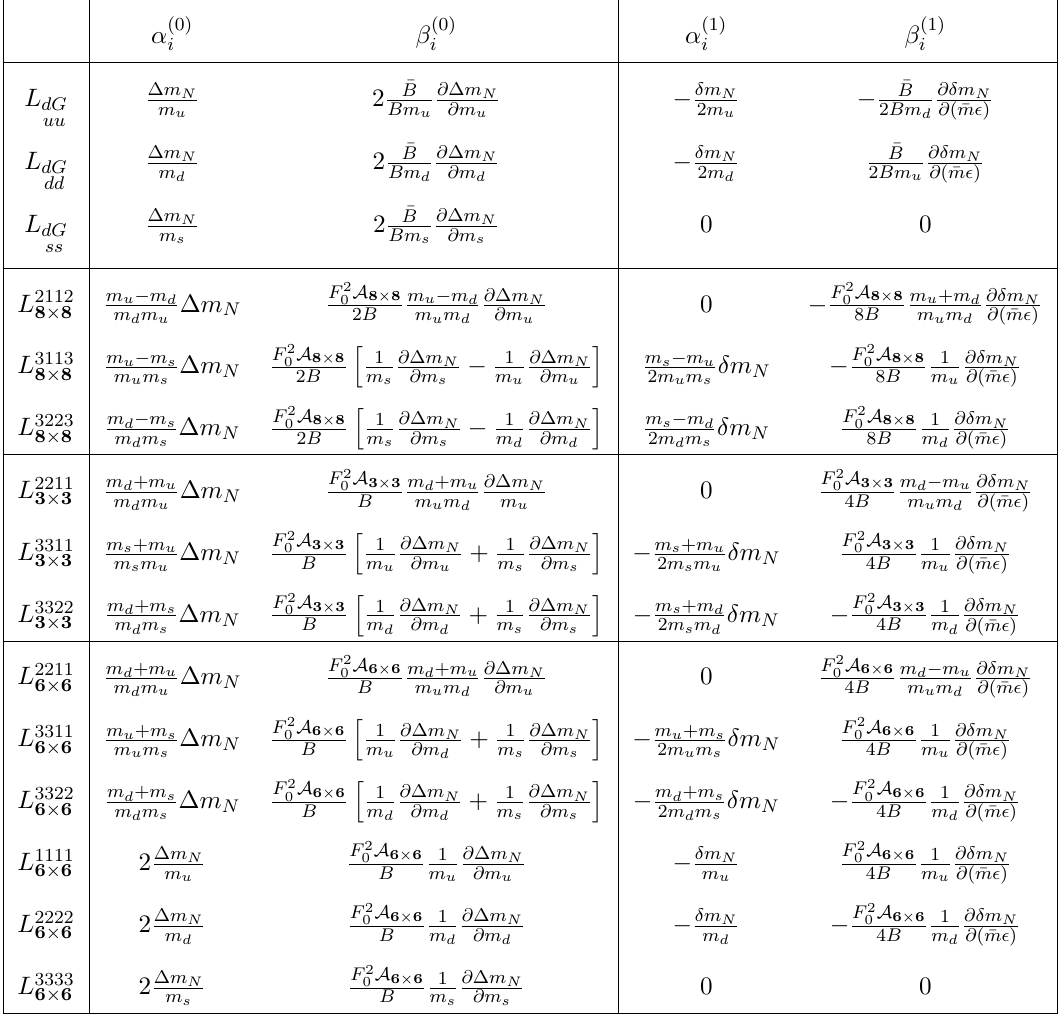
Table 2 . Coefficients determining the contributions to the axion-nucleon couplings. g (0 , 1) h P m ∗ ∂ α (0 , 1) i f a ∂ Re L i